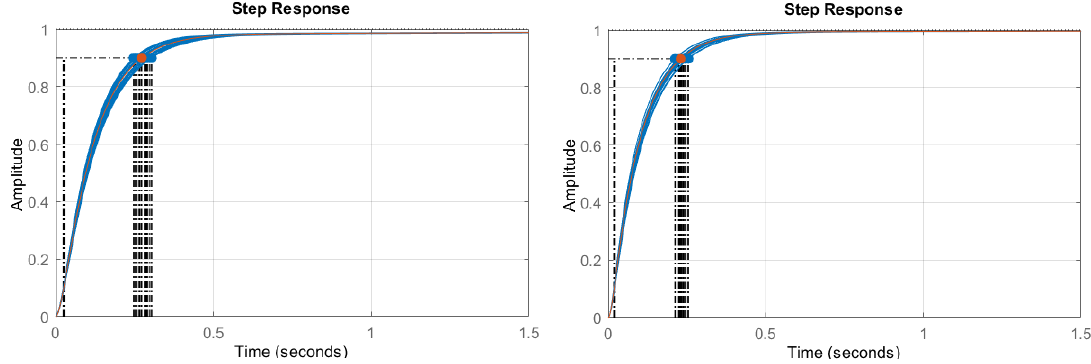
Figure 5. Time-domain closed-loop FO - PID performances for r x → θ x and r y → θ y